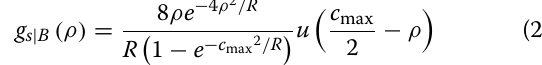
The MM-LINC pdf is obtained applying the total prob- ability theorem with the conditional probability in the LINC mode in (16)